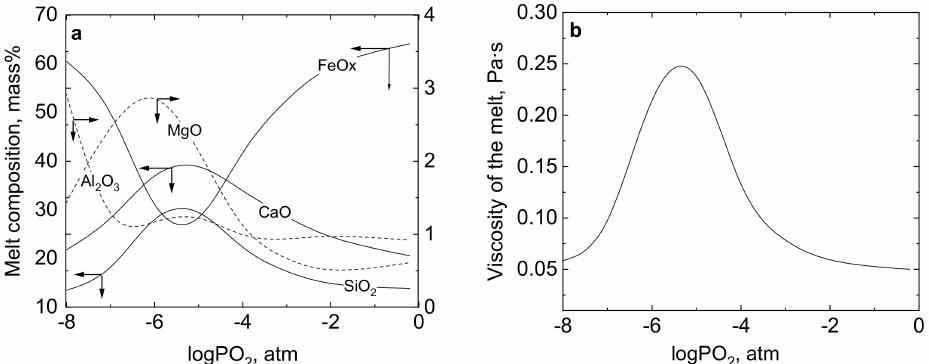
Figure 8. ( a ) Composition of the liquid melt formed at 1573 K and ( b ) the viscosity of the melt under various oxygen partial